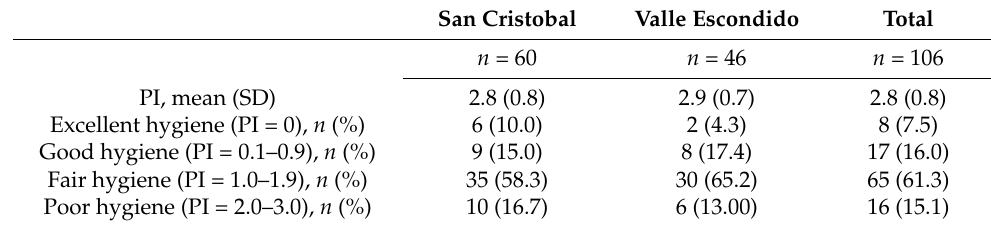
Table 2. Plaque index in the study population.